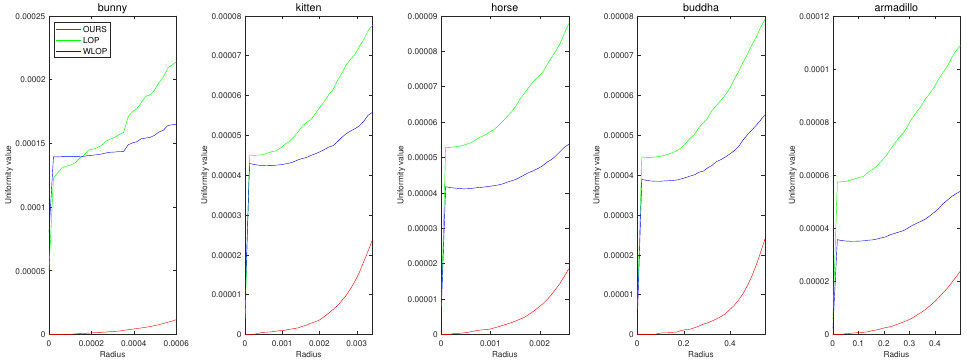
Figure 16. Quantitative results for the omnidirectional noise cases with resampling ratio 2.0. Each column represents different input data (first column: Horse; second column: Bunny; third column: Kitten; fourth column: Buddha; and fifth column: Armadillo).